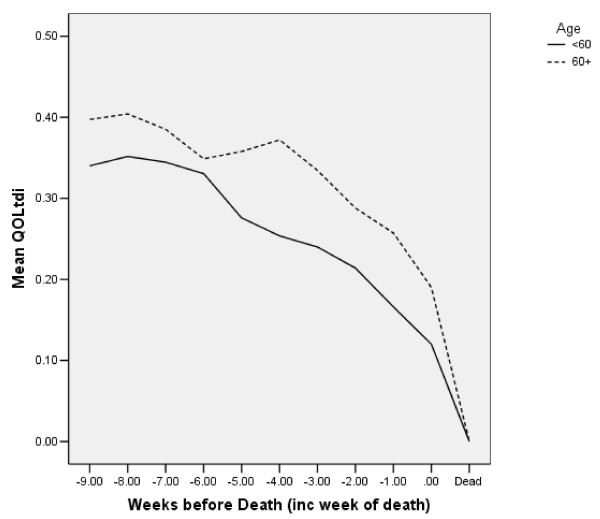
Mean QOLtdi in 10 weeks before death, by age (N = 83). The dotted line is age ≥ 60, the solid is age < 60.